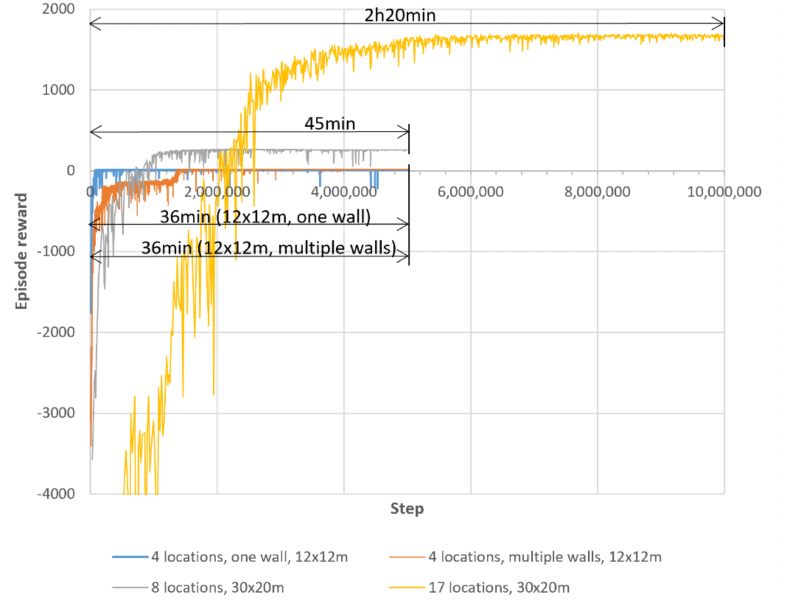
Figure 12. Episode reward during training and training times for different layouts. Tests were running on a mobile workstation with Intel Core i7–9750H Processor (12 × 2.6 GHz) and 32 GB